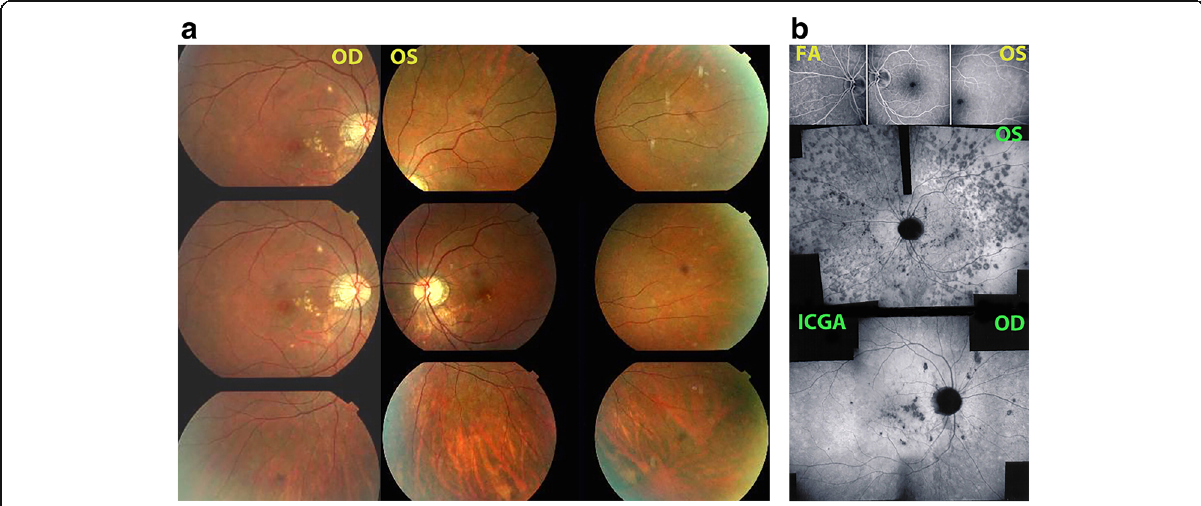
Fig. 3 Multifocal choroiditis (MFC) Fundus pictures ODS. Typical chorioretinal scars OD in inactive stage. OS minimal number of scars in an eye with photopsias and subjective scotomas with widespread occult choriocapillaritis (see Fig. 3b). b. Multifocal choroiditis (MFC) Occult choriocapillaritis. ICGA and FA in same patient as Fig. 3a. OS: vast areas of ICGA hypofluorescence indicating choriocapillaris hypo or non- perfusion. These zones indicate that in some cases the inflammatory process is involving vast areas of choriocapillaris non-perfusion that can be a trigger for the development of CNVs. In OD ICGA only shows inactive hypofluorescent scars without occult activity. FA (3 top frames) shows no more than slight late hyperfluorescence (middle and right